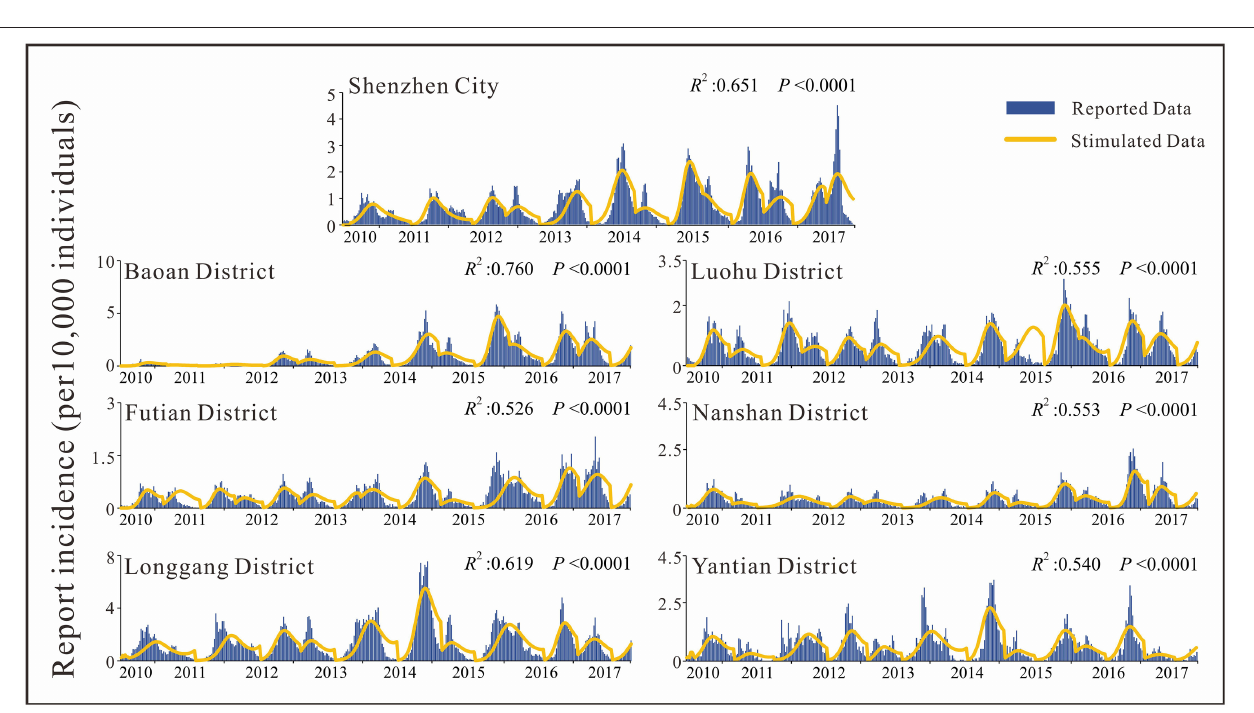
Frontiers in Public Health |